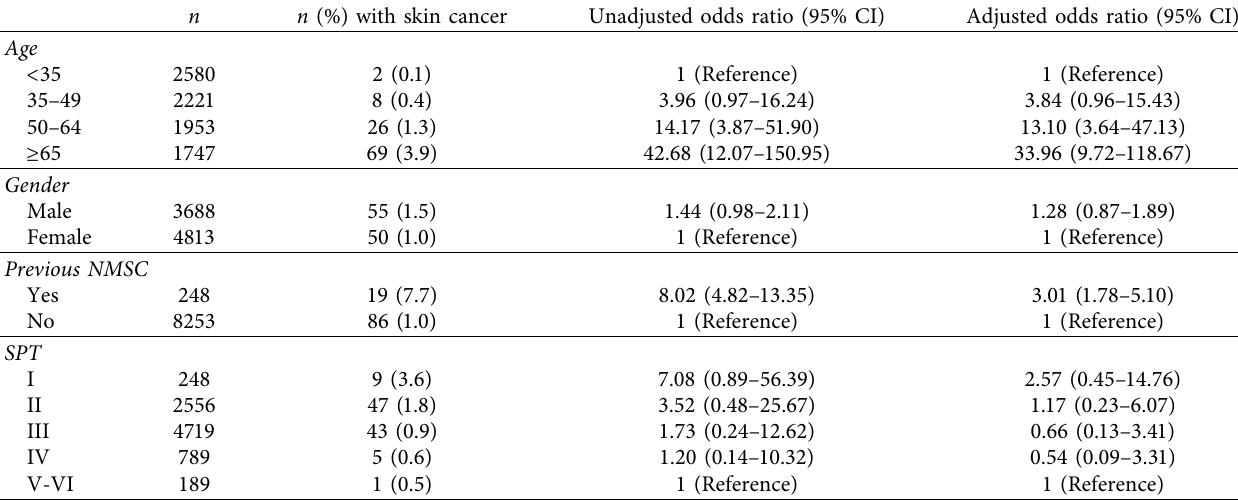
Table 1: Potential predictors of skin cancer on screening TBSE.